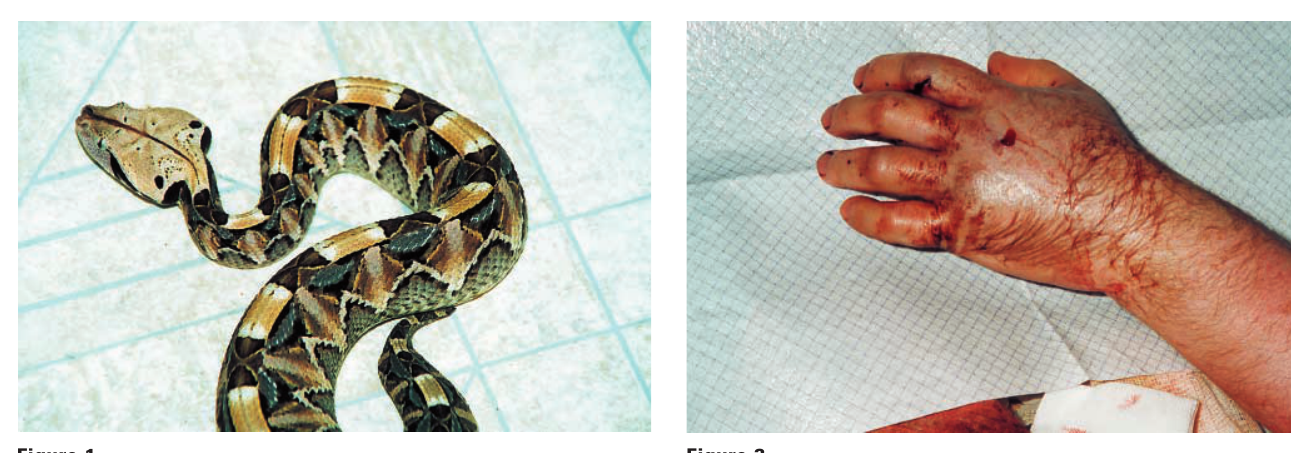
Figure 1 Gaboon viper ( Bitis gabonica ).